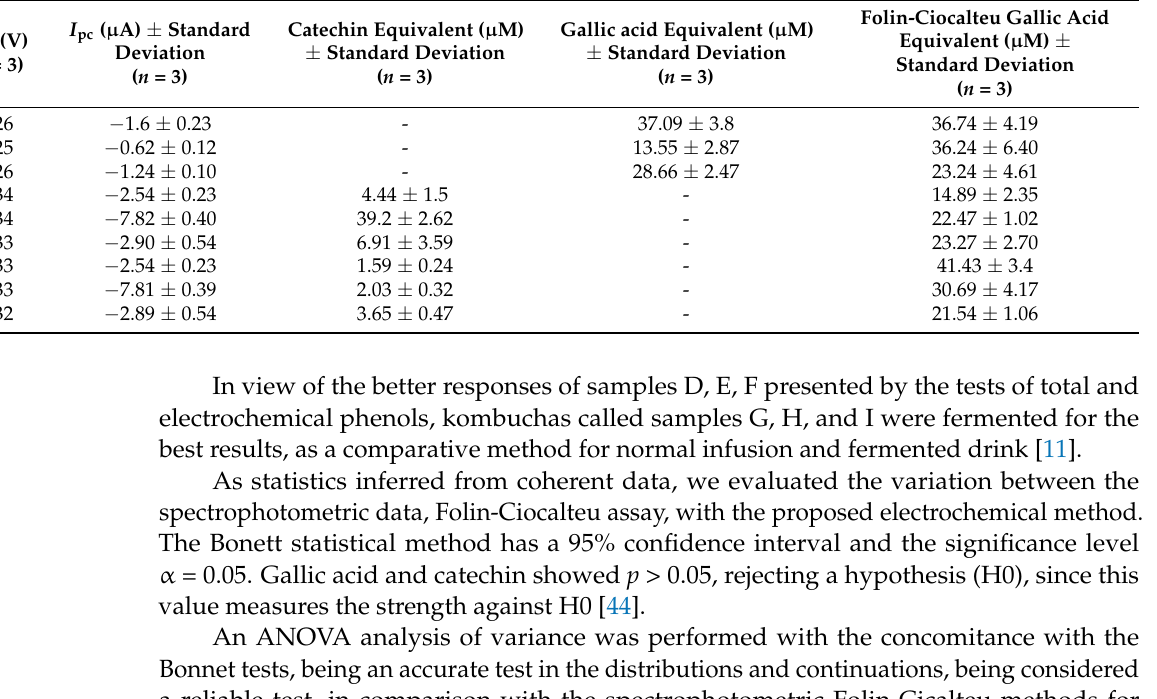
marker; Figure S2: Evaluation of commercial green tea of different samples and brands of a–f by HPLC, infused for 2 min. Mobile phase 0.1% phosphoric acid: Methanol. Gradient elution mode, detection per-formed at 280 nm